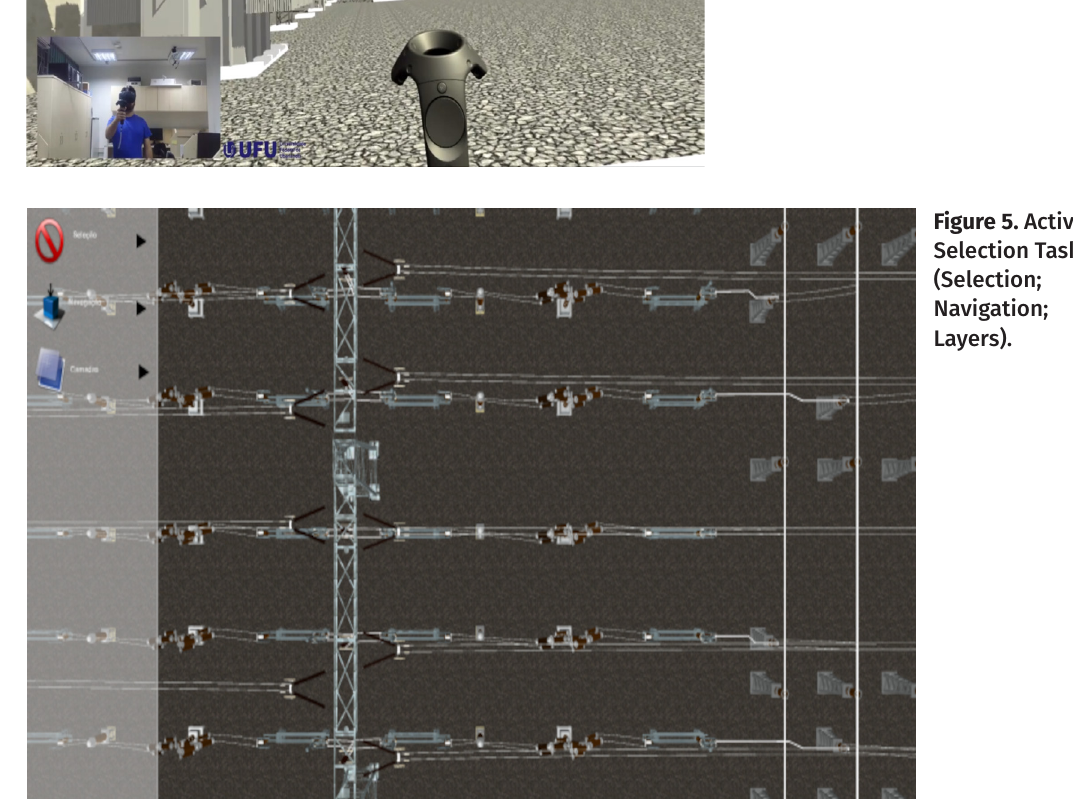
Figure 4. The lower- left corner of the picture shows the user interacting in the entirely immersive utilizing HMD HTC Vive.